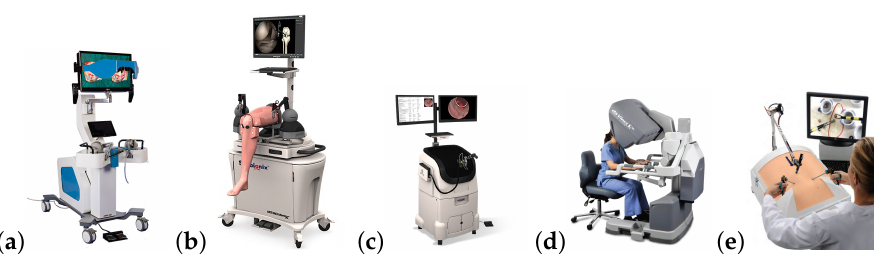
Figure 1. Examples of commercial stations for surgery and training: ( a ) Canadian Aviation Electronics (CAE) NeuroVR, ( b ) Simbionix Arthro Mentor, ( c ) Simbionix TURP Mentor, ( d ) Surgical System da Vinci Si, and ( e ) CAE